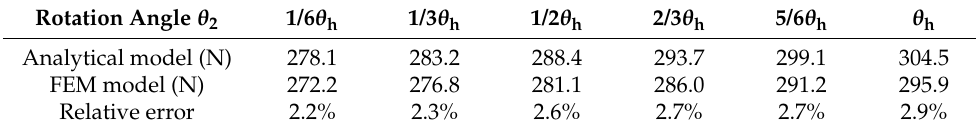
Table 3. Comparison of contact forces between the analytical model and the FEM model. Rotation Angle θ